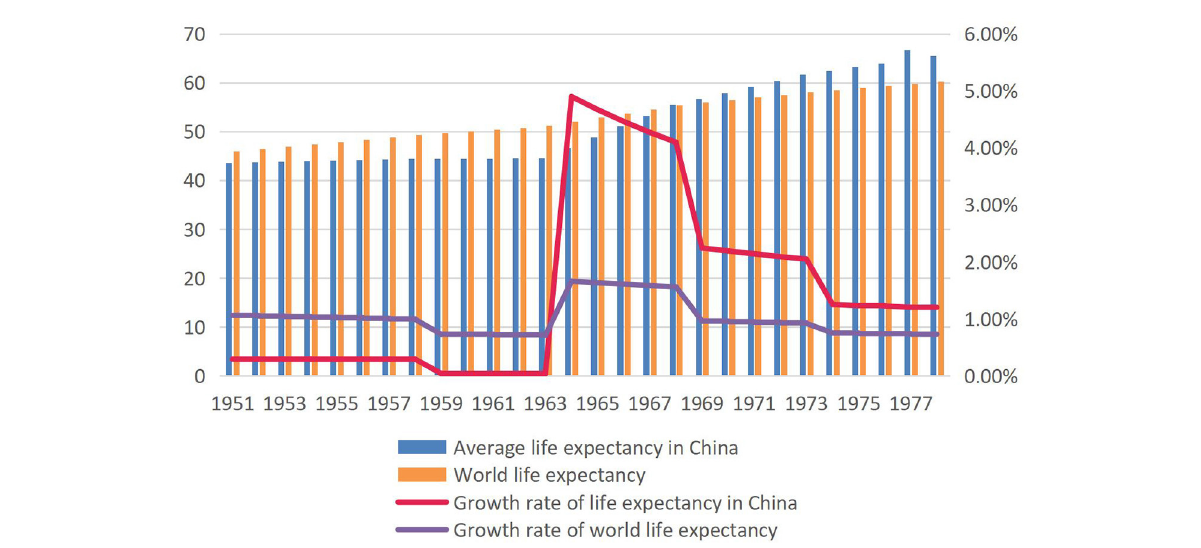
FIGURE1 Average life expectancy and growth rate of the world and China, 1951–1978 (16, 17). The average life expectancy in China was lower than the world average life expectancy in 1951 and the gap gradually widened between 1951 and 1963. Since 1964, the growth rate of China’s average life expectancy has risen rapidly, far higher than that of the world. In 1967, China’s average life expectancy was equal to the world’s average life